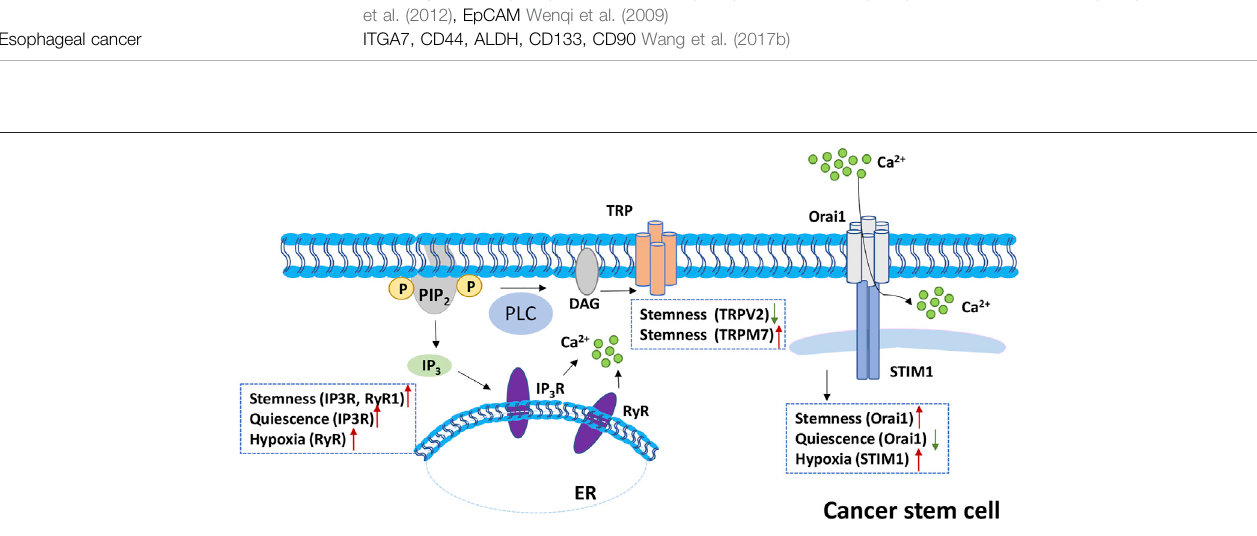
FIGURE1| Role ofSOCE in cancerstem cell(CSC). Left,IP3R and RyR areCa 2+ channels onthe ERmembrane.Activation ofIP3R or RyRchannelsrelease Ca 2+ from ER to cytoplasm. In CSC, IP3R and RyR promote stemness and quiescence. RyR also contributes to the cell hypoxia microenvironment. Middle, TRP family is involved in the stemness maintenance of CSC with negative and positive regulation of TRPV2 and TRPM7 separately. Right, Orai1 is upregulated in CSC assisting stemness maintenance; the downregulation of Orai1 promote quiescence maintenance. While STIM1 positively regulates CSC hypoxia